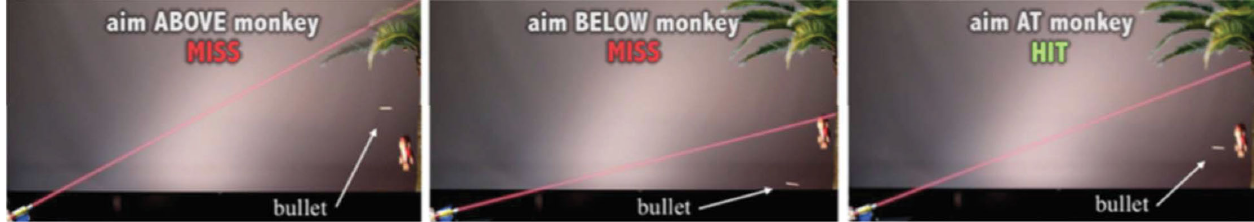
FIG. 3. Screenshots from the shoot the monkey demo video versions which had enhanced visuals (versions 1 and